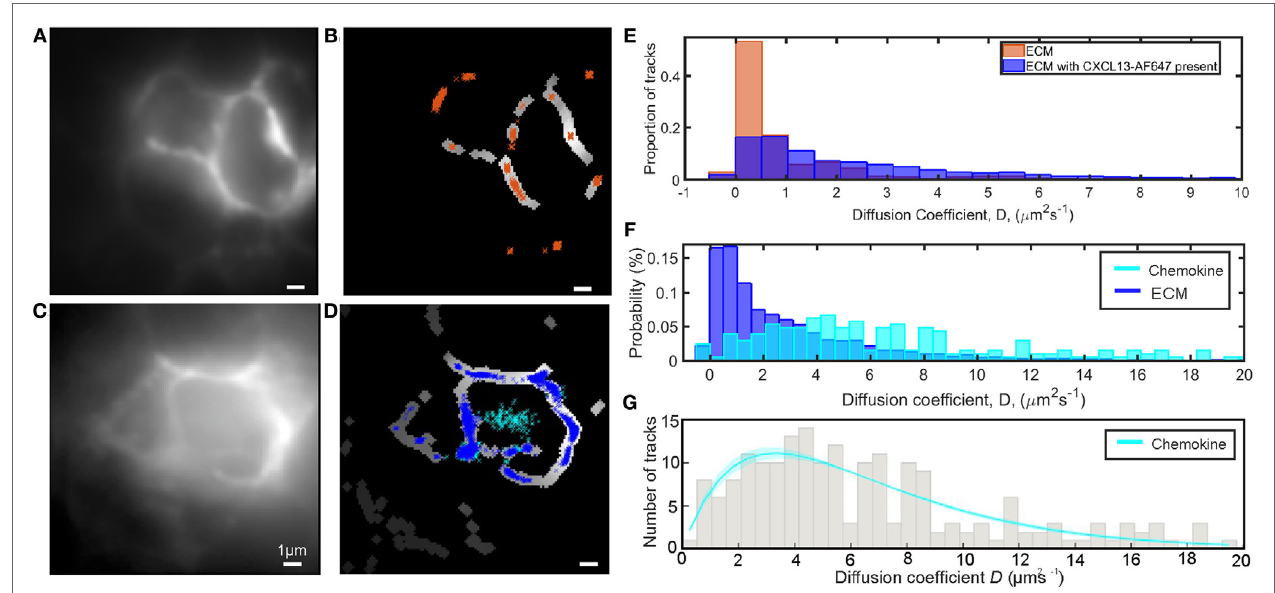
FigUre 7 | Single-molecule analysis of CXCL13-AF647 in tissue. (a) Intensity average image of image acquisition to show autofluorescent extracellular matrix (ECM) in B220-stained B-cell follicle with no added chemokine. (B) Areas of (a) identified as ECM by segmentation with overlaid track localizations colored orange. (c) Intensity average image of image acquisition to show autofluorescent ECM in B220-stained B-cell follicle with added chemokine. (D) Areas of (c) identified as ECM by segmentation with overlaid track localizations colored by location on ECM (blue) or in the interstitial spaces between cells (cyan). (e) Comparison of diffusion coefficients of localizations in ECM locations in the presence (blue) and absence (orange) of CXCL13-AF647 (F) Comparison of diffusion coefficients for the ECM (blue) and chemokine (cyan) populations when tracking CXCL13-AF647 in lymph node tissue shown. (g) Distribution and fit of chemokine diffusion coefficients of CXC13-AF647 in tissue sections, shaded area indicates one